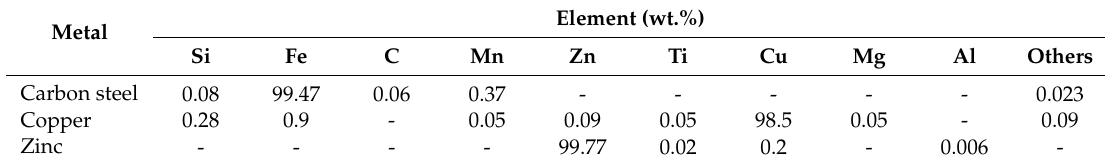
Table 1. Chemical composition of the carbon steel, zinc, and copper test samples.